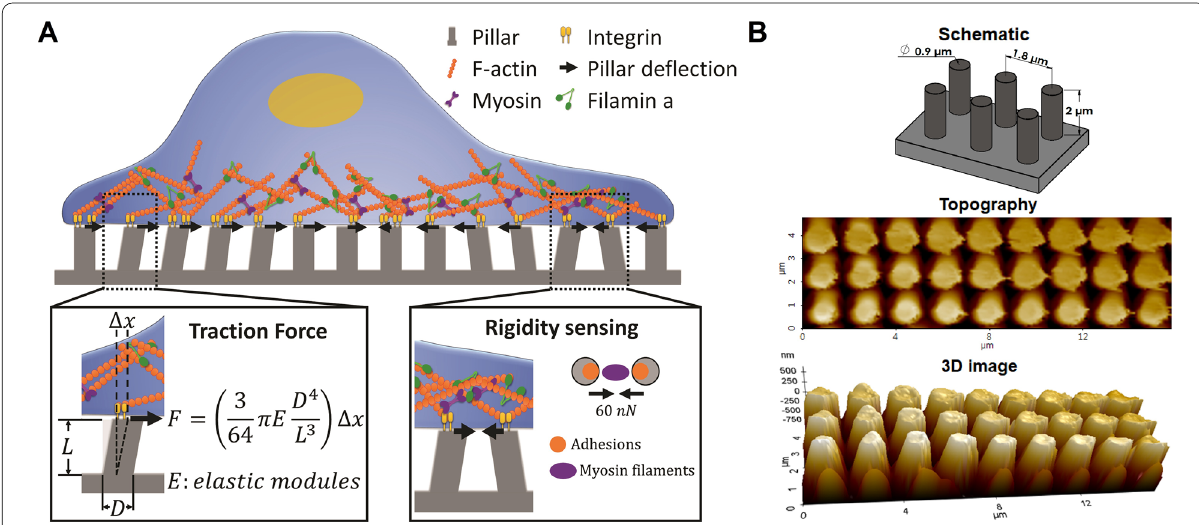
Fig. 1 A Schematic describing traction forces (TFs) and rigidity sensing in a cell. F, D, L and E represent TF, the diameter, length, and Young’s modulus of PDMS, respectively. ∆x ; the displacement of the pillar. B Schematic and AFM (2D and 3D) topographical images of the pillar arrays. The AFM image of the pillar array was taken in ambient conditions in a contact mode. It shows that the diameter of pillars and center-to-center (c-t-c) distance between pillars are 900 nm and 1.8 μm